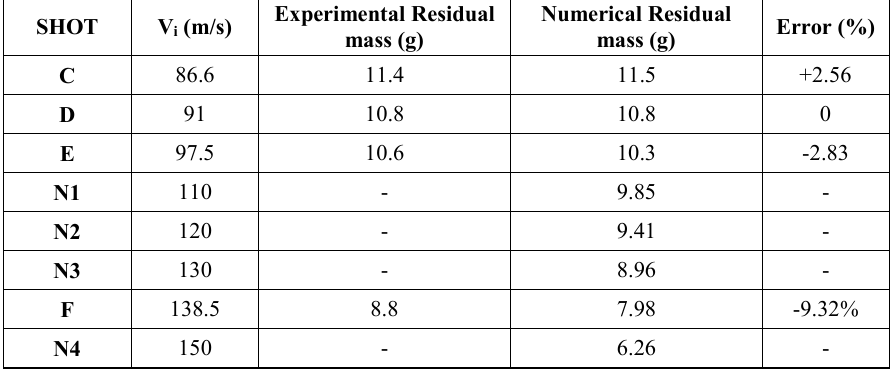
Table 2. Comparison of experimental and numerical residual masses at different impact velocities. Experimental SHOT